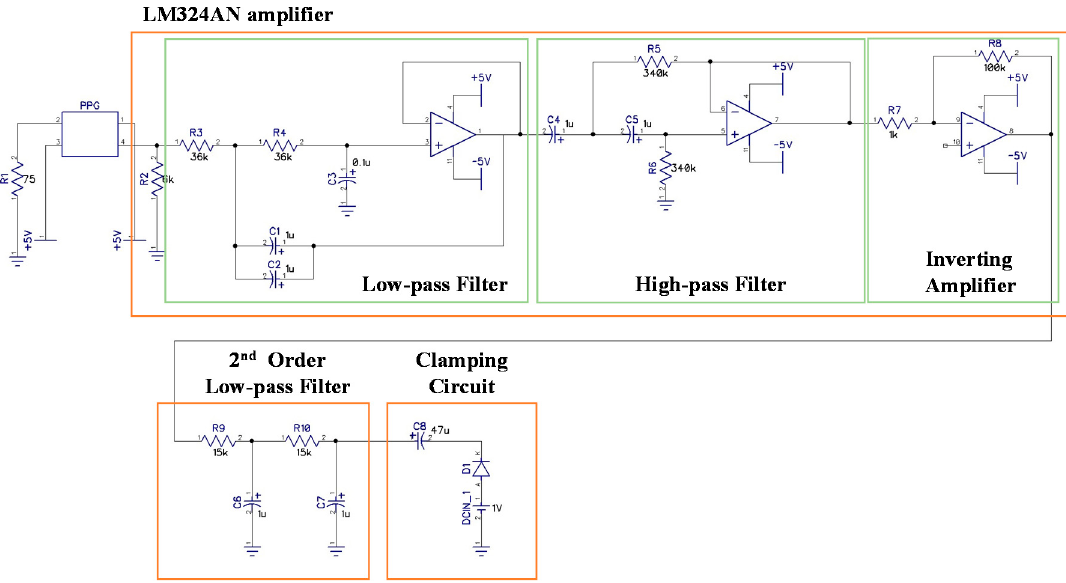
Figure 8. Schematic of the front-end circuit designed for the photoplethysmography (PPG) sensor.